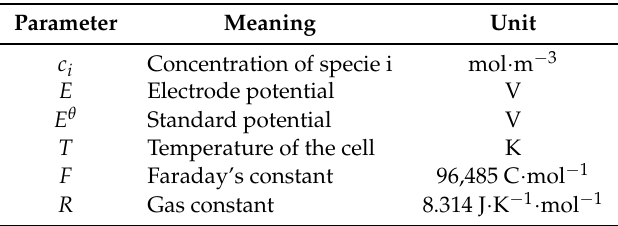
Table 2. Parameters and constants for Nerst Equation, (5). Parameter Meaning